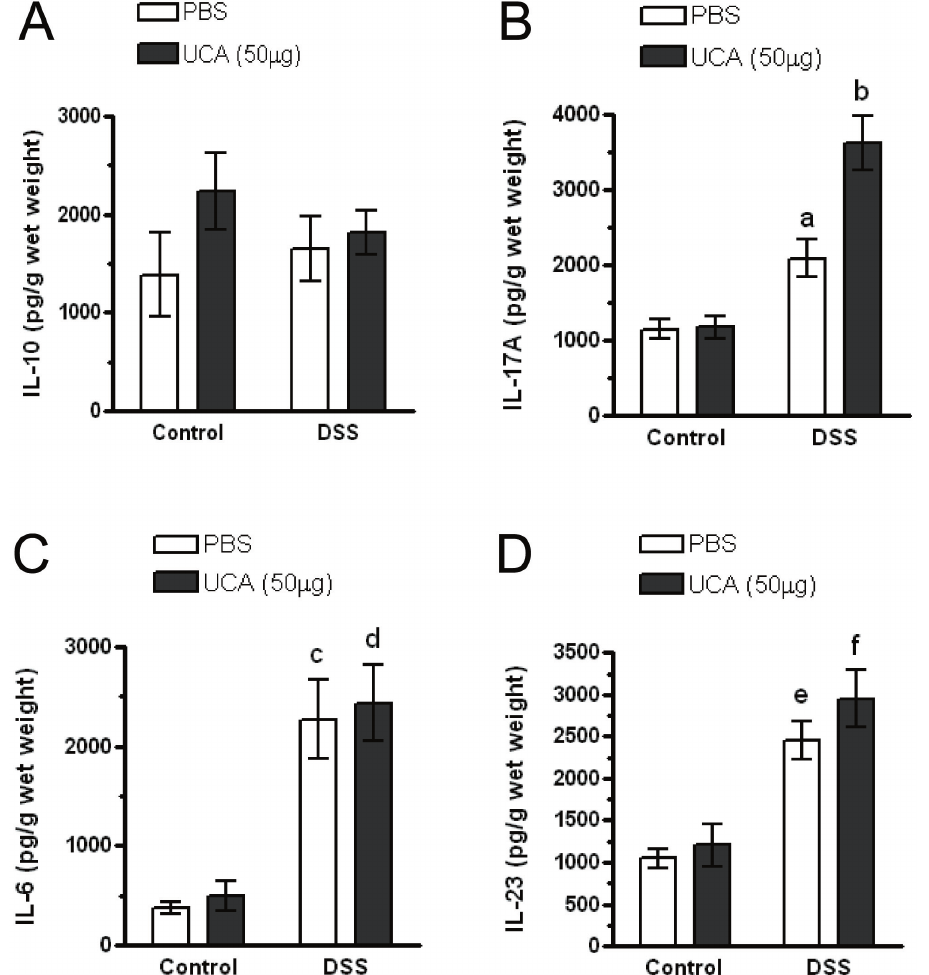
Figure 2. Effect of cis -UCA and DSS on tissue cytokines. 129Sv/Ev mice were treated with 5% DSS for 7 days to induce acute colitis. Beginning on the first day of DSS administration mice were injected subcutaneously along the dorsal axis daily for 7 days with 50 m g cis -UCA or vehicle (PBS). Colonic tissue was ultrasonicated and supernatants were analyzed for total levels of cytokines. cis -UCA and DSS had no significant effects on tissue levels of IL-10 (A). DSS treated mice had increased levels of IL-17, and these were further increased in mice treated with cis -UCA (50 m g) (B). DSS treated mice had increased levels of colonic IL-6 (C) and IL-23 (D) and these values were not altered by cis -UCA (50 m g) n=5–25 for all measurements. a: p , 0.01 DSS + PBS compared with control PBS, control UCA (50 m g), and DSS + UCA (50 m g). b: p , 0.01 DSS + UCA (50 m g) compared with control PBS and control UCA (50 m g). c: p , 0.01 DSS + PBS compared with control PBS, and control UCA (50 m g). d: p , 0.01 DSS + UCA (50 m g) compared with control PBS, and control UCA (50 m g). e: p , 0.01 DSS + PBS compared with control PBS, and control UCA (50 m g). f: p , 0.01 DSS + UCA (50 m g) compared with control PBS, and control UCA (50 m g).